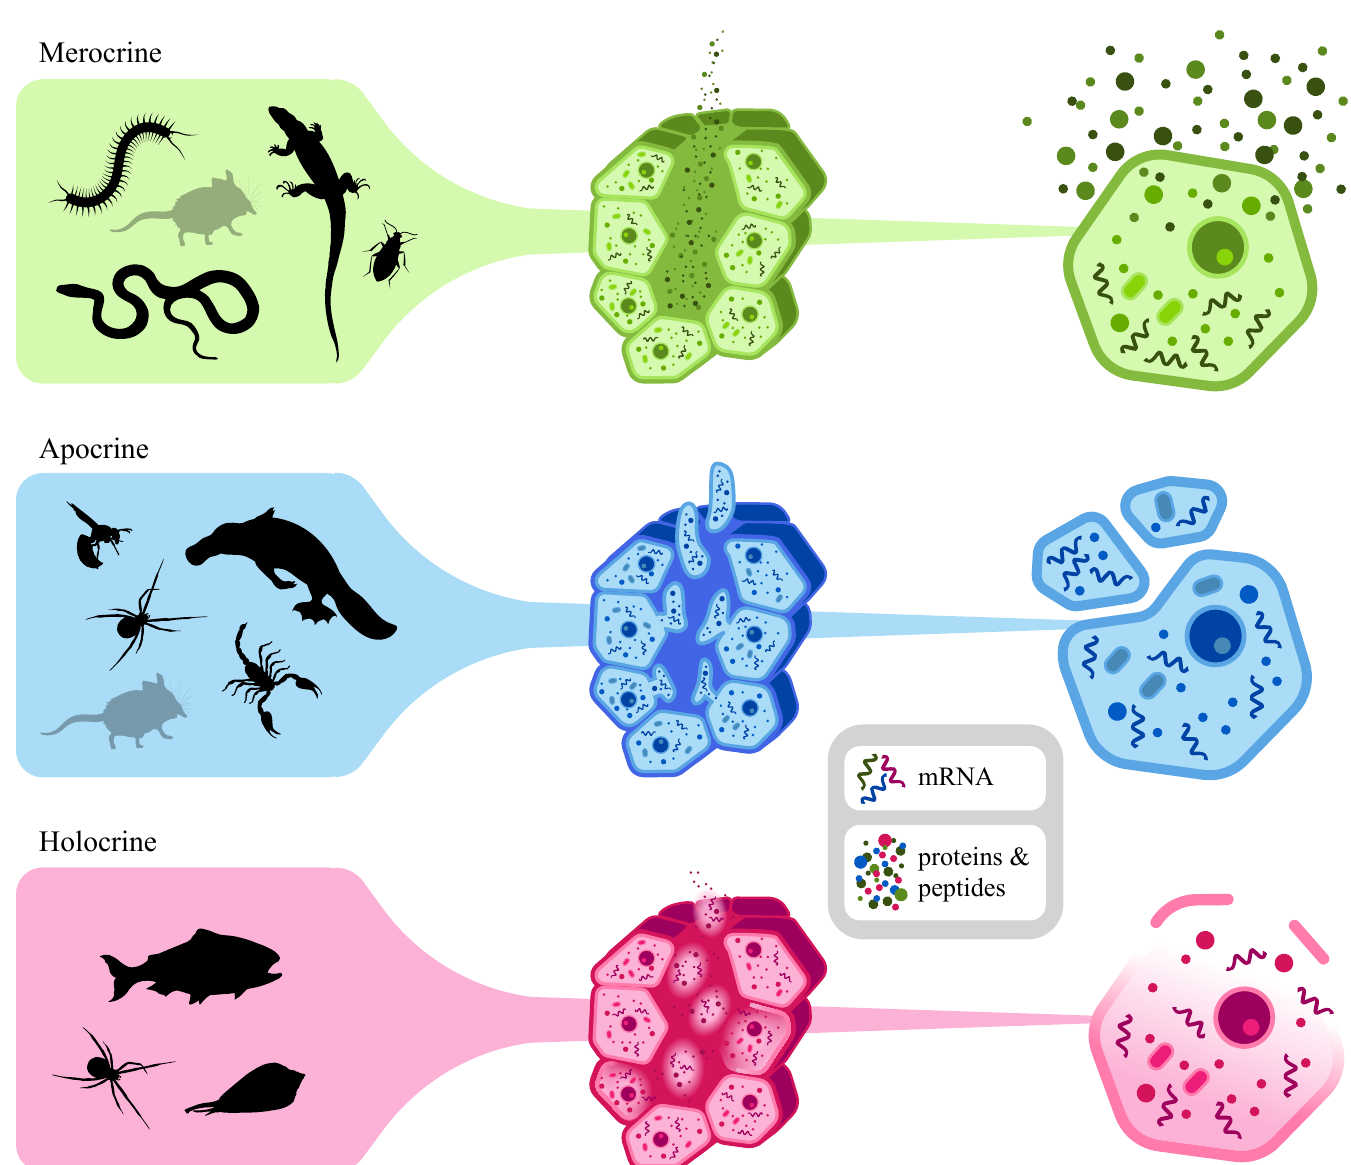
Fig 3. Schematic overview of the three secretion methods in the venom glands across the animal kingdom. The left panel shows the various venomous lineages, clustered based on the method of secretion of their venom-producing cells. For some lineages the gland type depends on the species and therefore these are represented multiple times in this figure. Note that some clades are shown in grey, as literature does not provide sufficient information to properly categorize these based on their method of venom secretion. The middle column of this figure shows a cartoon of excretory cells surrounding the gland lumen and right part of the figure schematically illustrates how venomous secretions are being produced by a single cell (see text for further